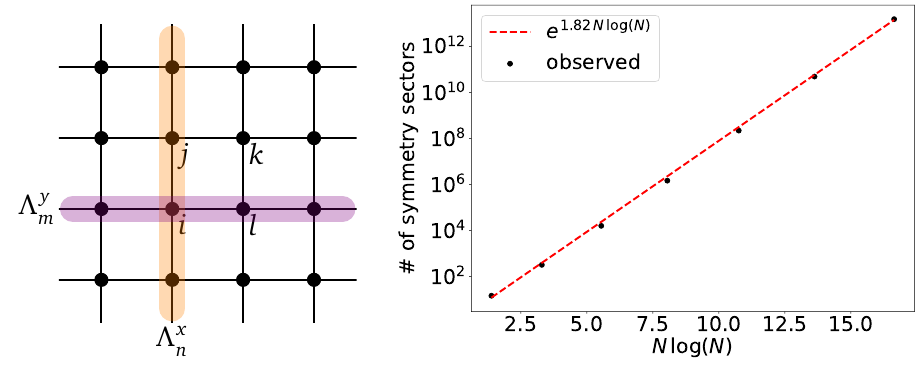
( α ) , ˆ U y ( α ) are defined on columns Λ x m n